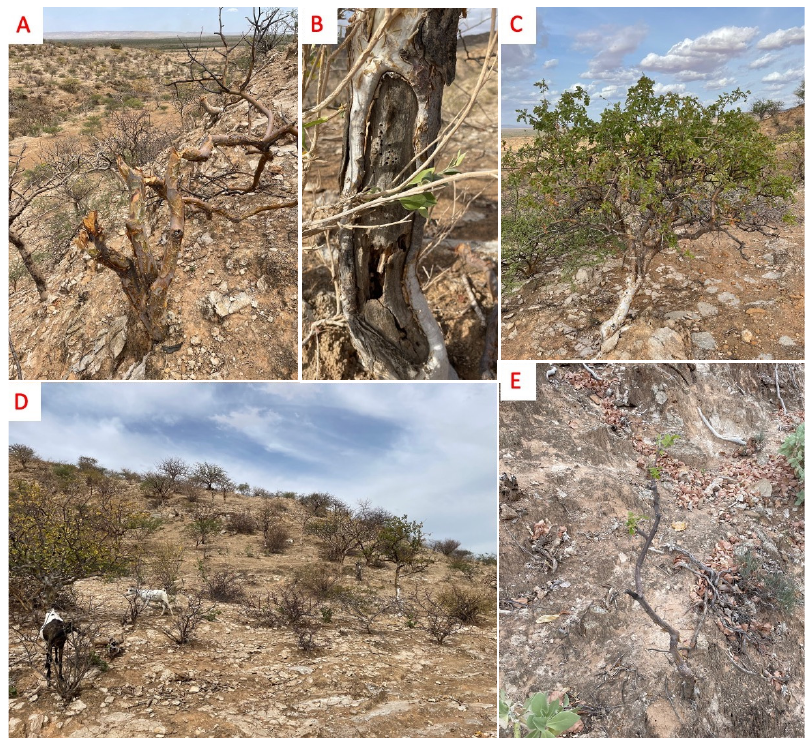
Figure 2. ( A ) Cut B. ogadensis tree; ( B ) Damage to B. ogadensis trunk showing insect attacks; ( C ) B. ogadensis individual; ( D ) Goats grazing on a hillside, with B. ogadensis visible in the background; ( E ) B. ogadensis